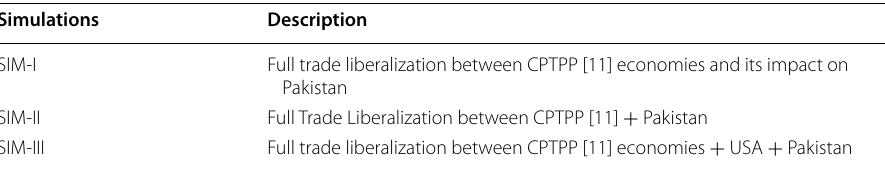
Table 2 Simulation used in this study